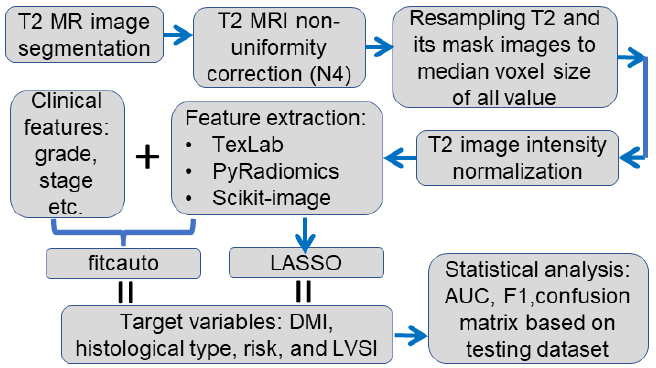
Figure 1. Data analysis pipeline. The arrows indicate the order of the analysis. fitcauto represents automatically selected classification model with optimized hyperparameters using fitcauto.m func- tion in MATLAB. LASSO: least absolute shrinkage and selection operator; AUC: area under the ROC